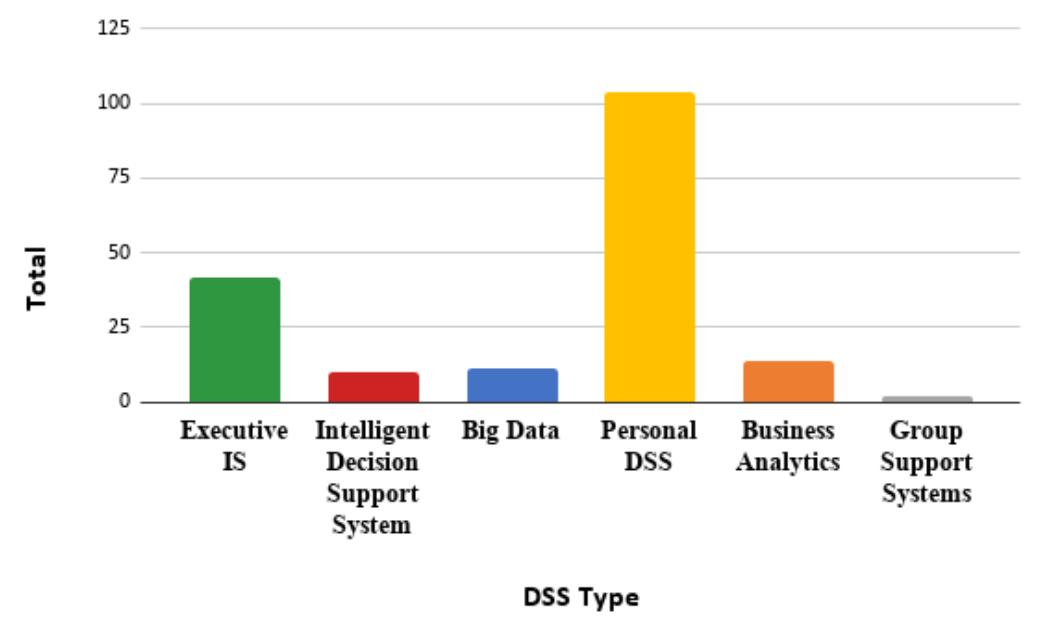
Figure 7. Number of studies by type of DSS. Figure 7 . Number of studies by type of DSS.